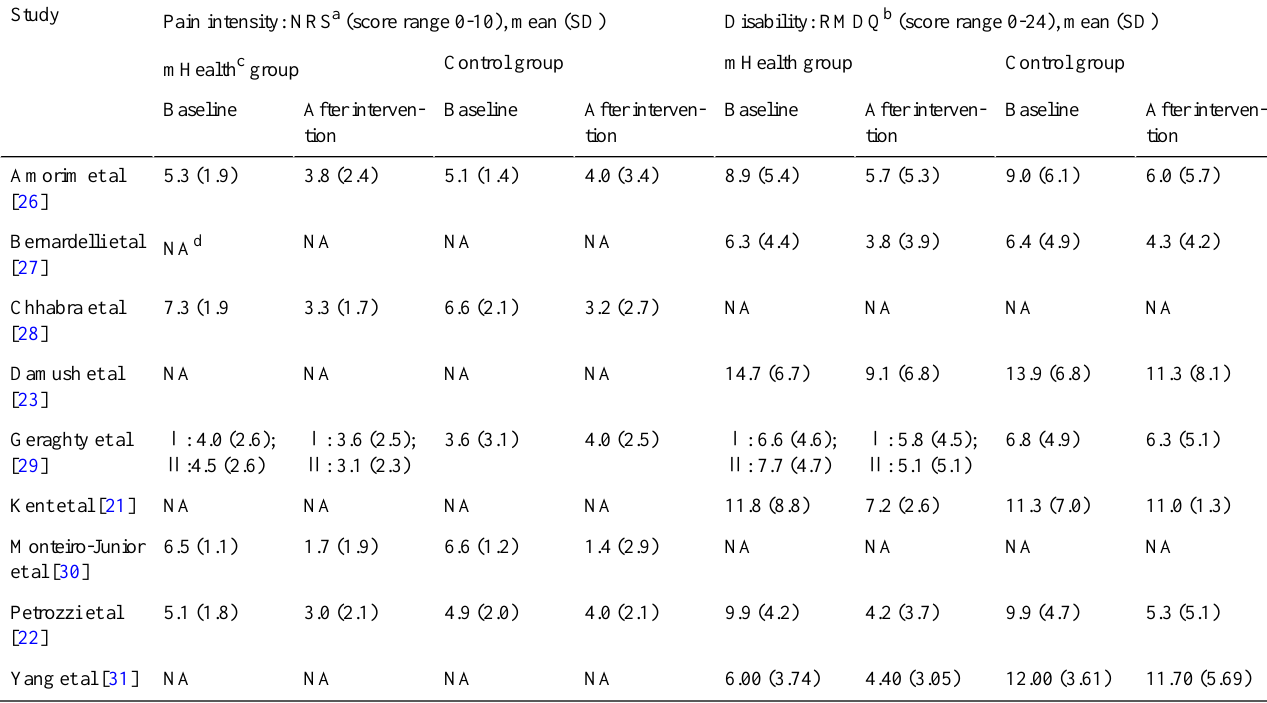
Table 1. Pain and disability scores at baseline and after the